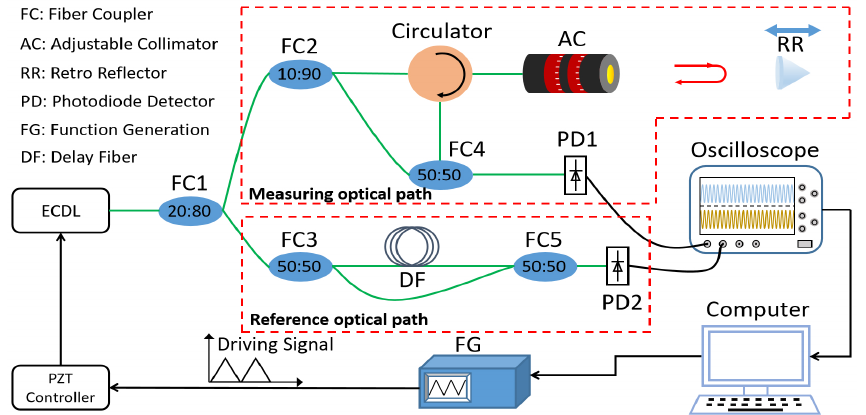
Figure 1. Schematic diagram of FSI ranging